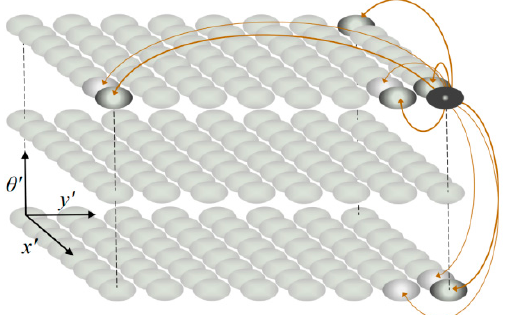
Figure 1. Three-dimensional competitive attractor network (CAN) model.